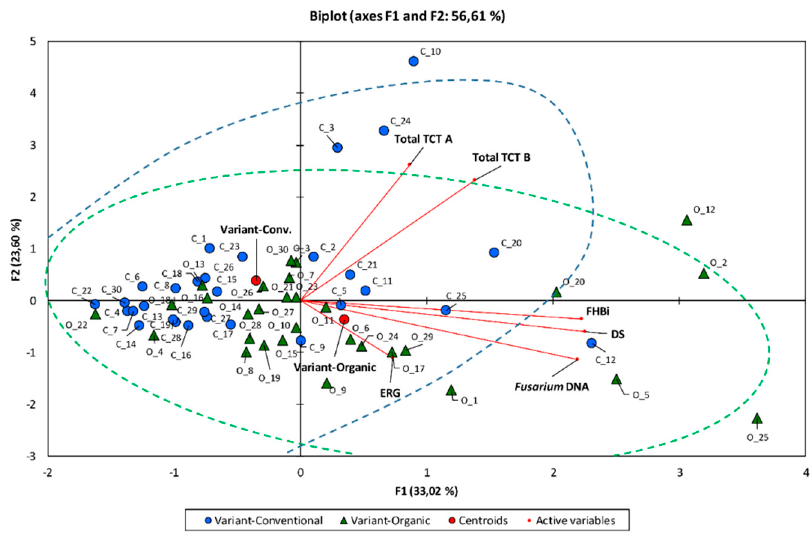
Figure 2. Biplot of the principal component analysis for 30 winter wheat cultivars grown in conventional (C) and organic field (O). Two first components explained 55.90% of variability of Fusarium head blight index (FHBi), dead seeds proportion (DS), ergosterol (ERG) and type A (Total TCT A) and type B (Total TCT B) trichothecenes content, and concentration of DNA ( Fusarium DNA) of five Fusarium species in grain. Samples from conventional field marked with circles and from organic field with triangles.